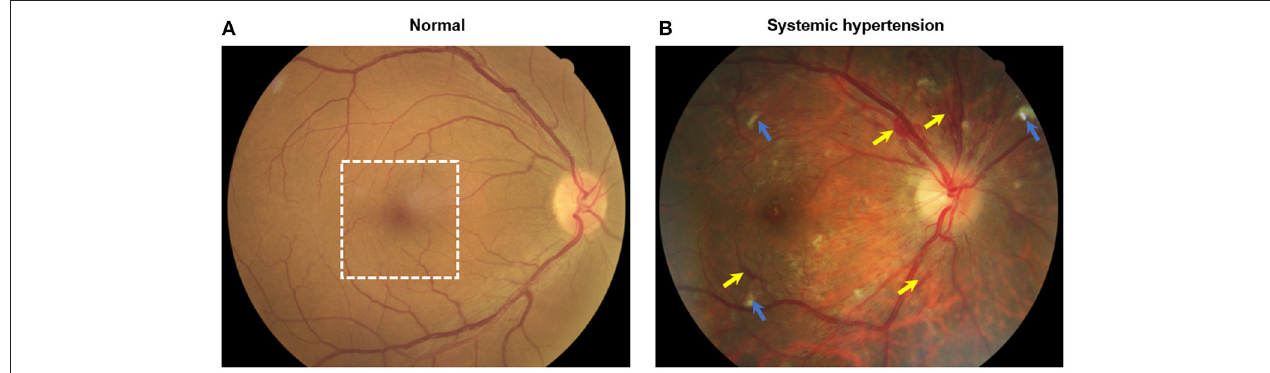
FIGURE 1 | Color fundus photographs of (A) an individual without systemic hypertension with normal eye and (B) a hypertensive person with signs of moderate hypertensive retinopathy. Notably features include flame hemorrhages (yellow arrows) and cotton wool spots (blue arrows). White dotted box indicates the optical coherence tomography angiography (OCTA, 3 × 3 mm 2 ) scanned region as seen in Figure 2